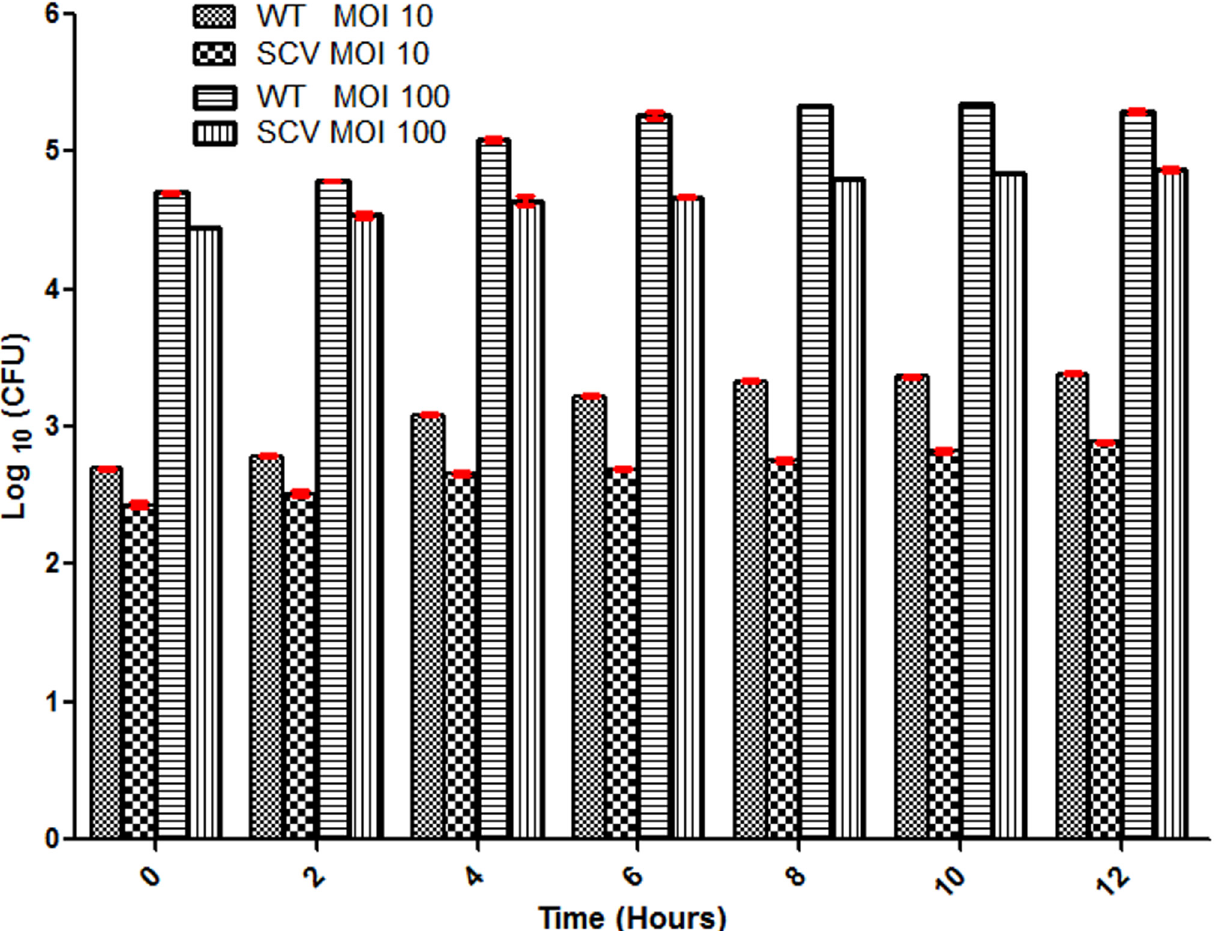
Fig 2. Intracellular survival of Burkholderia pseudomallei WT and SCV in A549 cells. Monolayers were infected with B . pseudomallei WT and SCV at a MOI of 1:10 and 1:100 and the intracellular loads of bacteria were quantified over 12 hours post-infection. The values are the means of each of three independent experiments, each performed in triplicate and error bar represents the standard